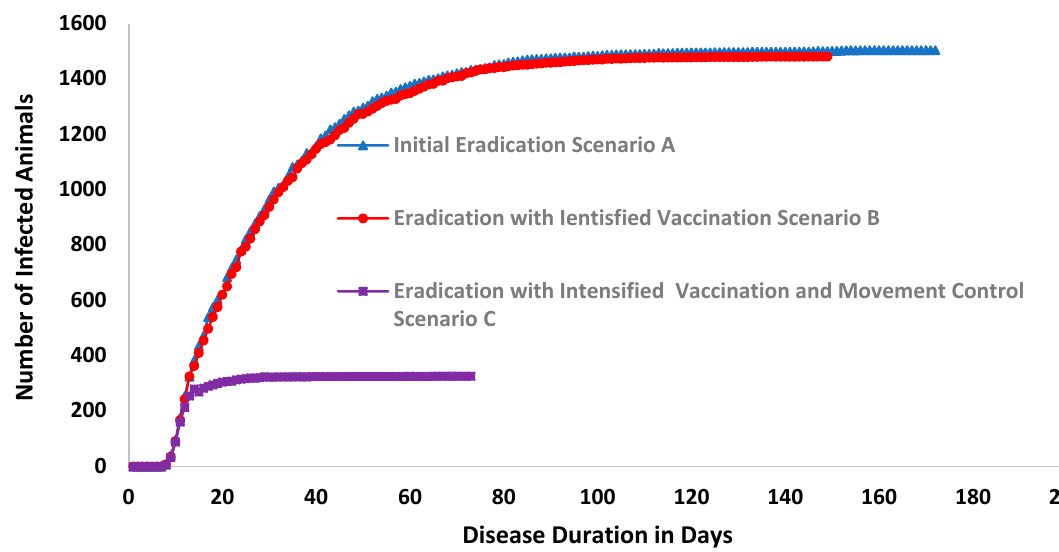
Figure 7. Cumulative number of infected animals and outbreak duration in the three scenarios.